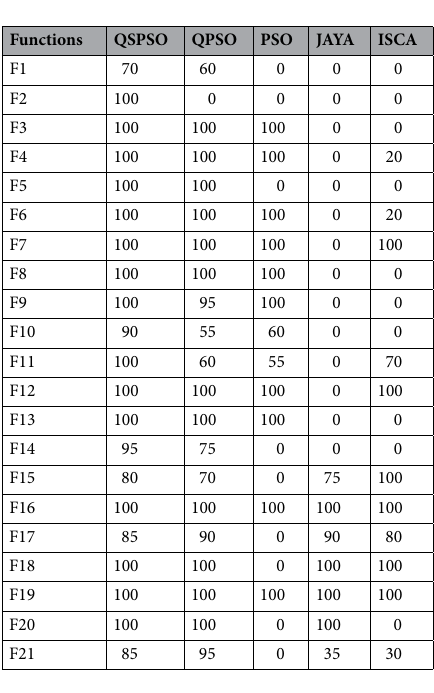
Table 5. Reliability of and comparisons among algorithms ( % ).